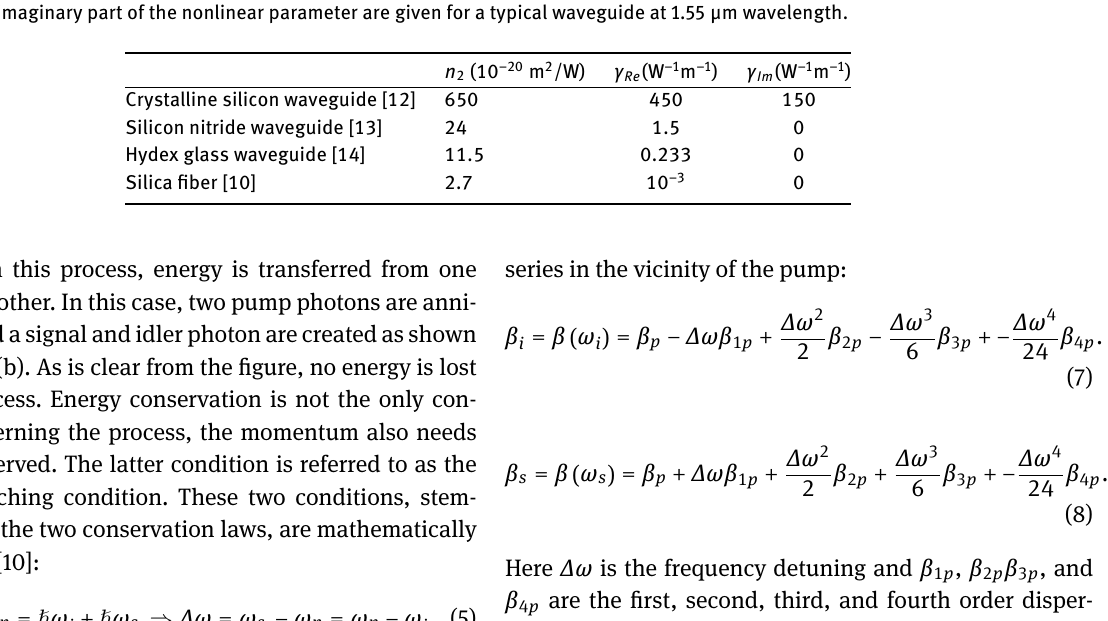
Table 1. The nonlinear refractive index and nonlinear parameter of some widely used Si-based materials and waveguide structures. Both the real and the imaginary part of the nonlinear parameter are given for a typical waveguide at 1.55 µm wavelength.